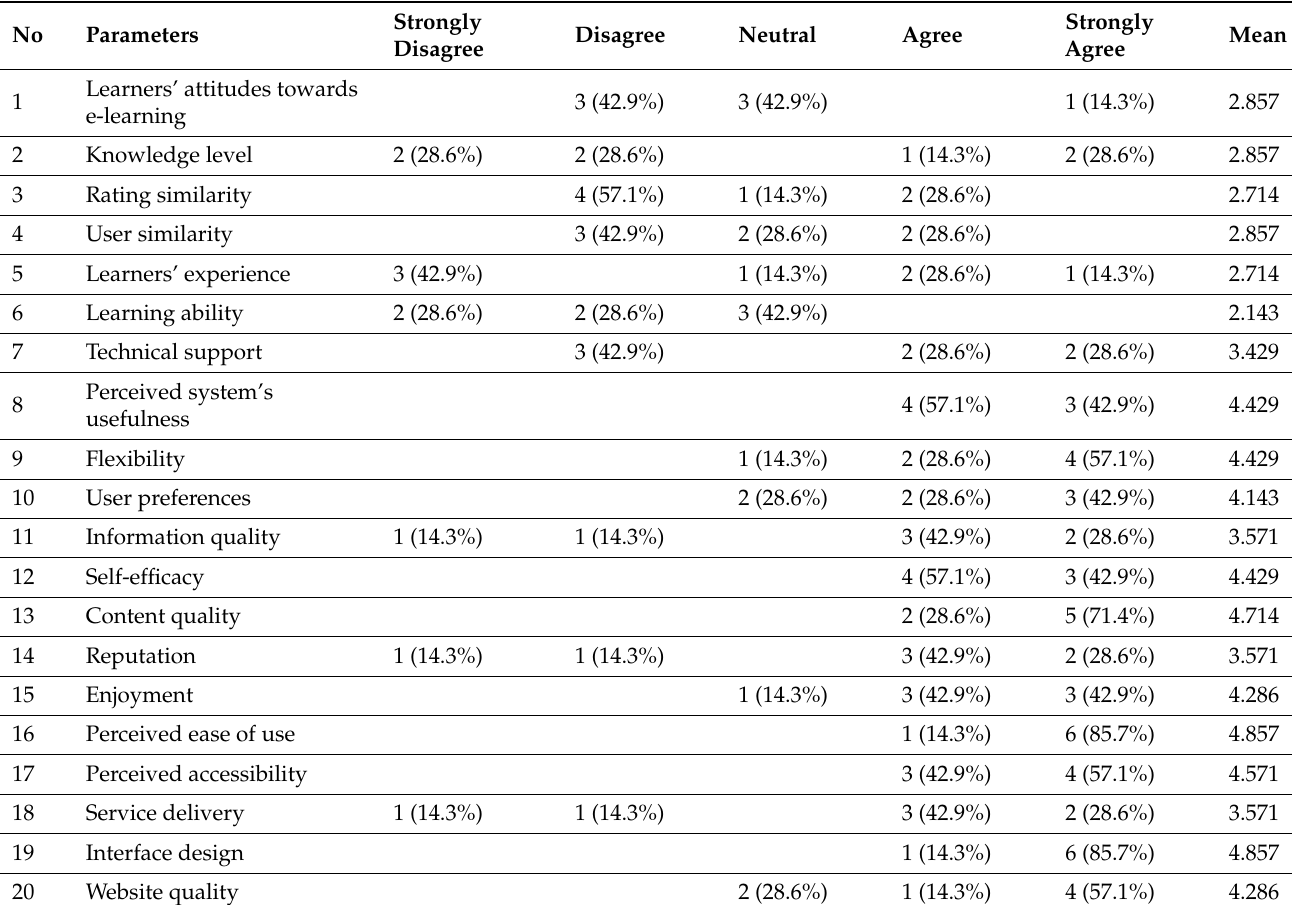
Table 2. Summary of parameters of iteration